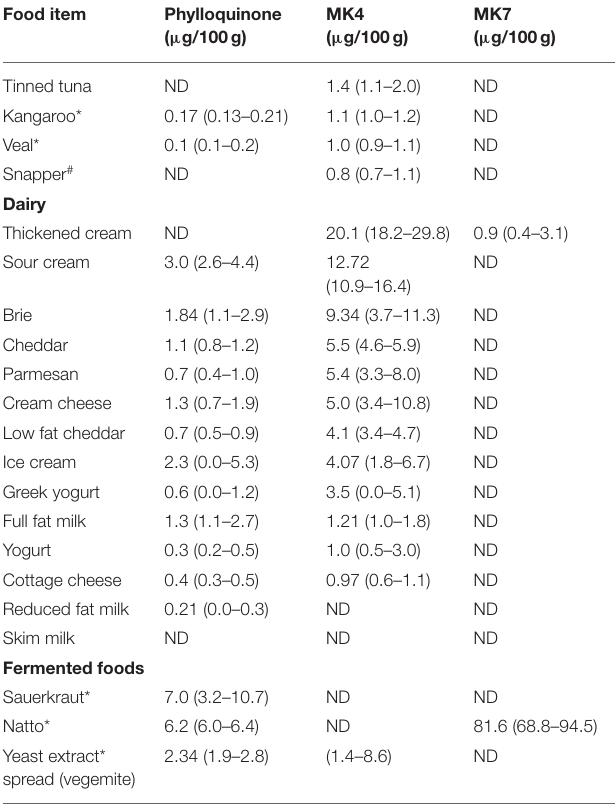
* Indicates mean value; ND, not detected. Three separate samples were analyzed for all food items apart from those indicated by # or * , where two or a single food item was analyzed, respectively. Each sample of food was also assessed in duplicate. Where only one food sample was analyzed (in duplicate), the mean and range has been presented